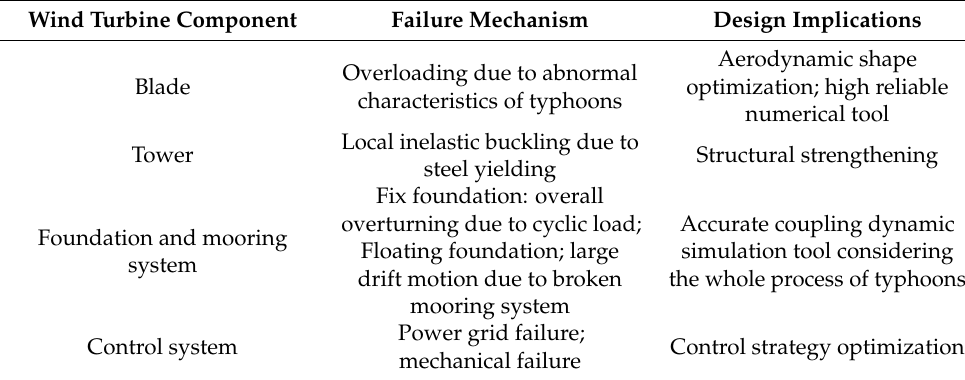
Table 3. Summary of failure mechanism and design implications of the offshore wind